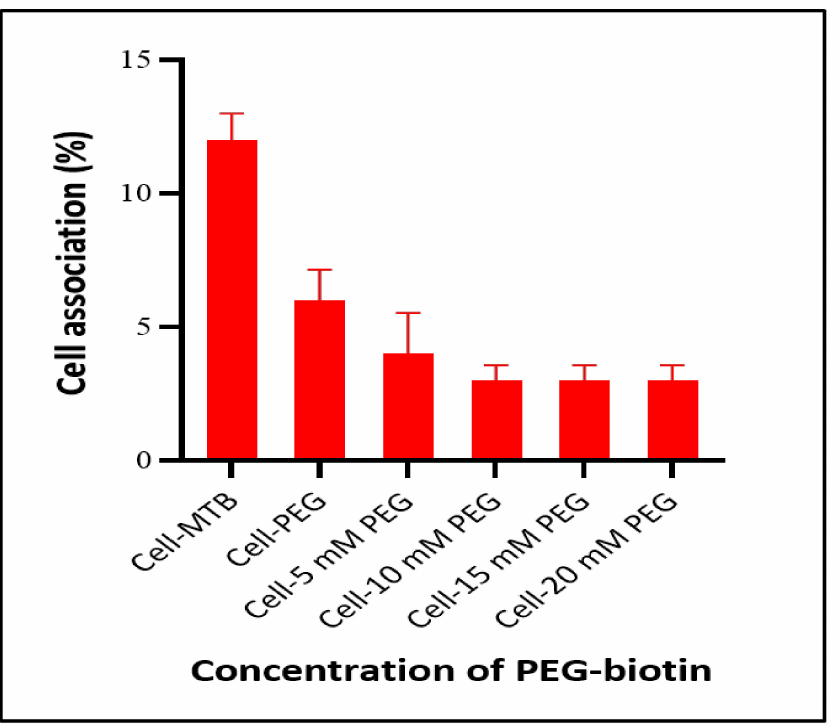
Figure 7. THP-1 cell association with different concentrations of PEG-biotin combined with MTB and bare MTB after 24 h of incubation at 37 ◦ C. Results indicate that THP-1 cells incubated with bare MTB showed a very high cell association (12%), whereas cells treated with the MTB/PEG–biotin complex displayed relatively less cell association. Data were normalized to untreated cells. Error bars, mean ± SD, n =